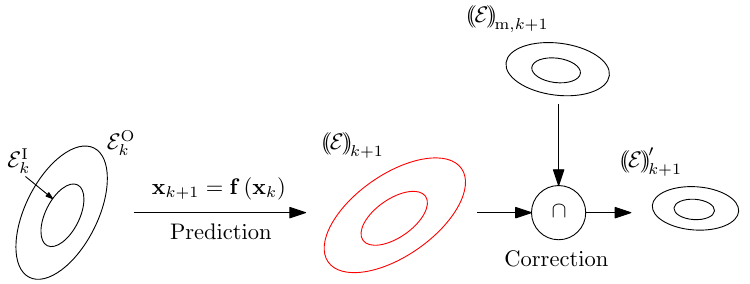
Figure 6. Thick ellipsoid state estimation algorithm consisting of prediction and correction